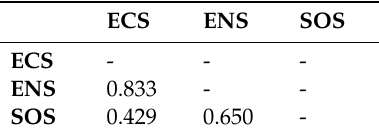
Table 7. Heterotrait–Monotrait Ratio (HTMT) criterion.